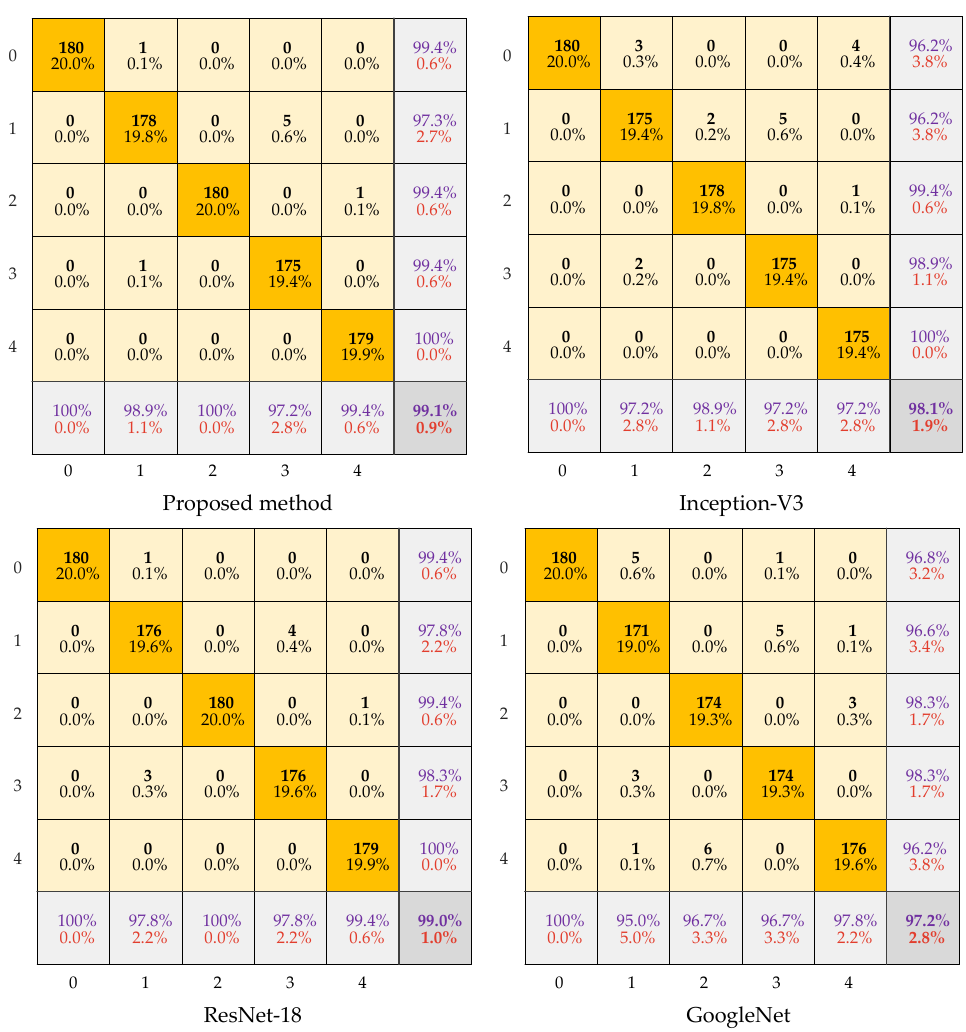
Table 4. The diagnostic performance of the different methods.